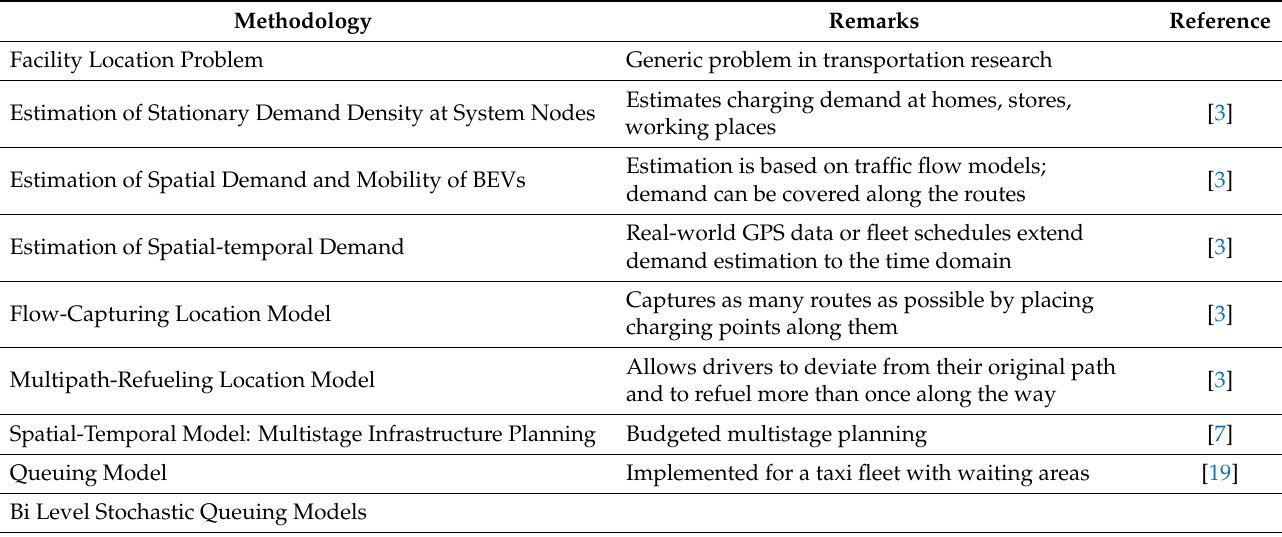
Table 2. Overview of modeling methodologies for vehicle fleets with the purpose of identifying suitable charging infrastructure.